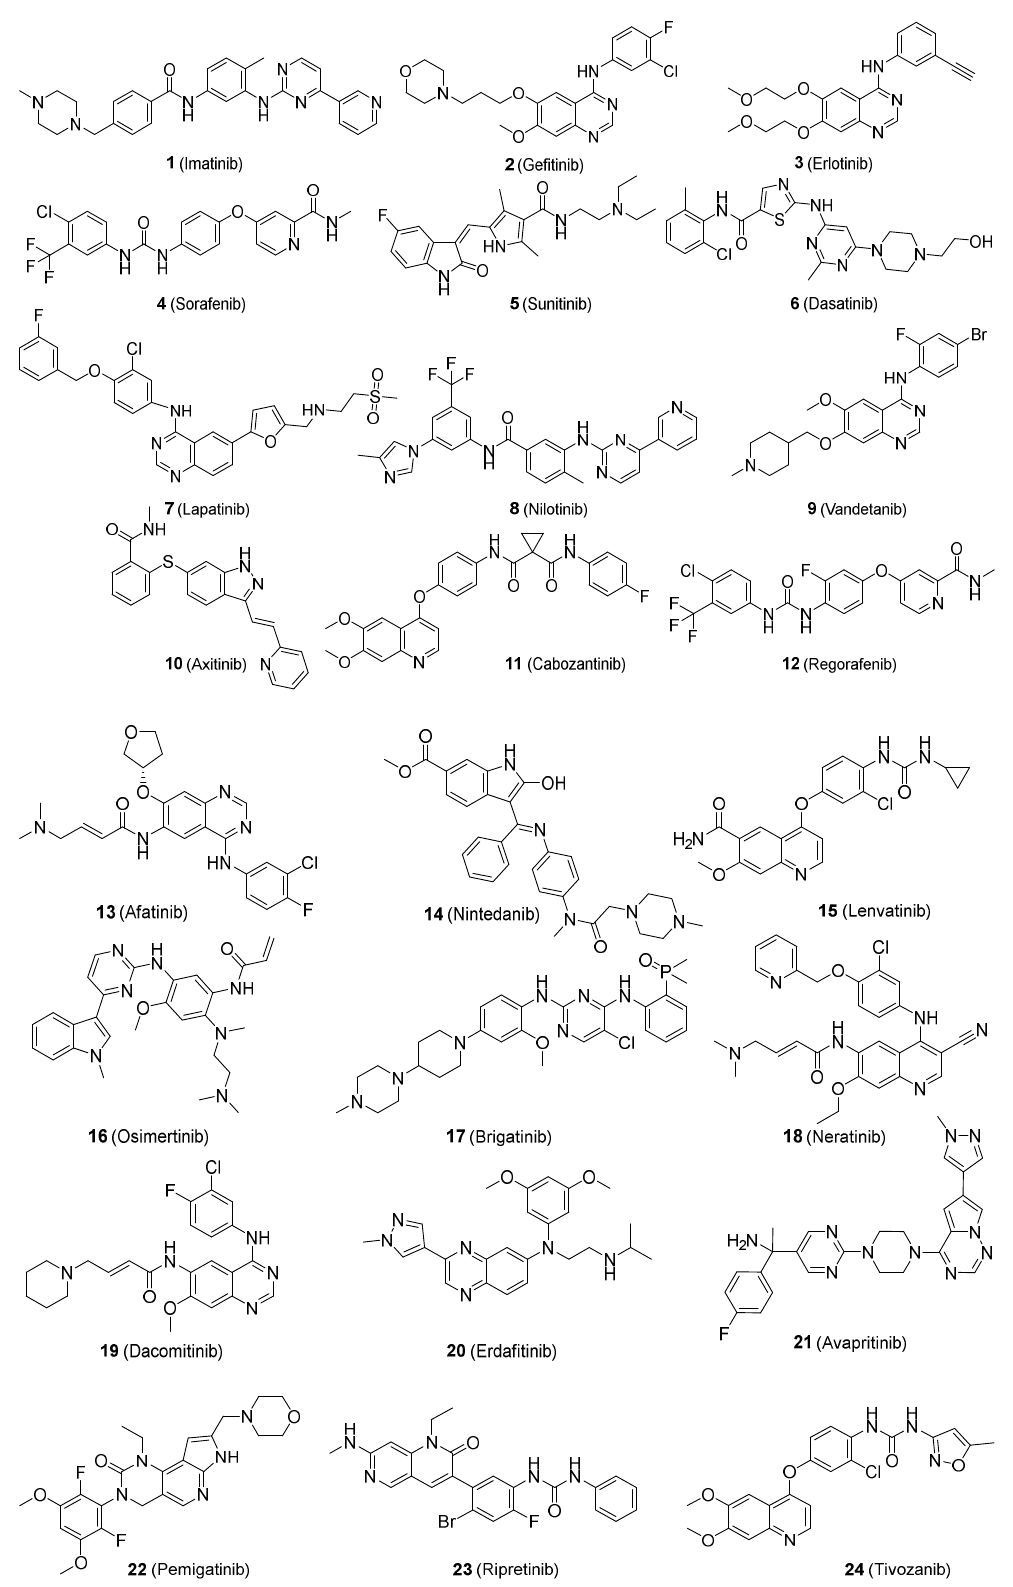
Figure 1. Tyrosine kinase inhibitors included in the database used for the comparative evaluation of the web servers.